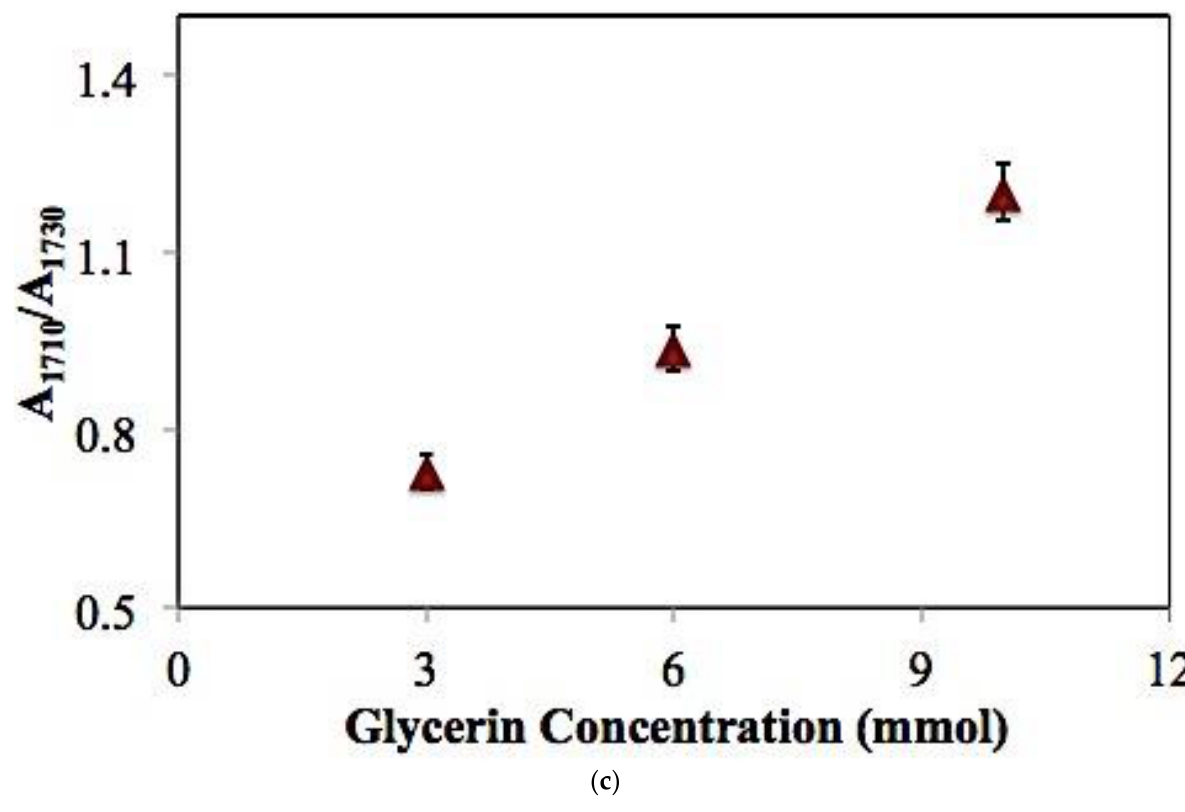
Figure 2. ( a ): FTIR spectra of PU crosslinked with varying concentrations of glycerin at low wavenumbers, showing variation in the ether, C-O-C and carbonyl, and C=O absorption peak with glycerin concentration. ( b ): FTIR spectra of PU crosslinked with varying concentrations of glycerin at high wavenumbers, showing variation in the secondary amine and N-H absorption peak with glycerin concentration. ( c ): Effect of glycerin concentration on the ratio of hydrogen-bonded carbonyl absorption at 1710 cm − 1 to free carbonyl absorption peak at 1730 cm − 1